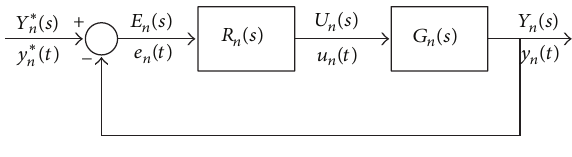
Figure 1: Unity feedback control